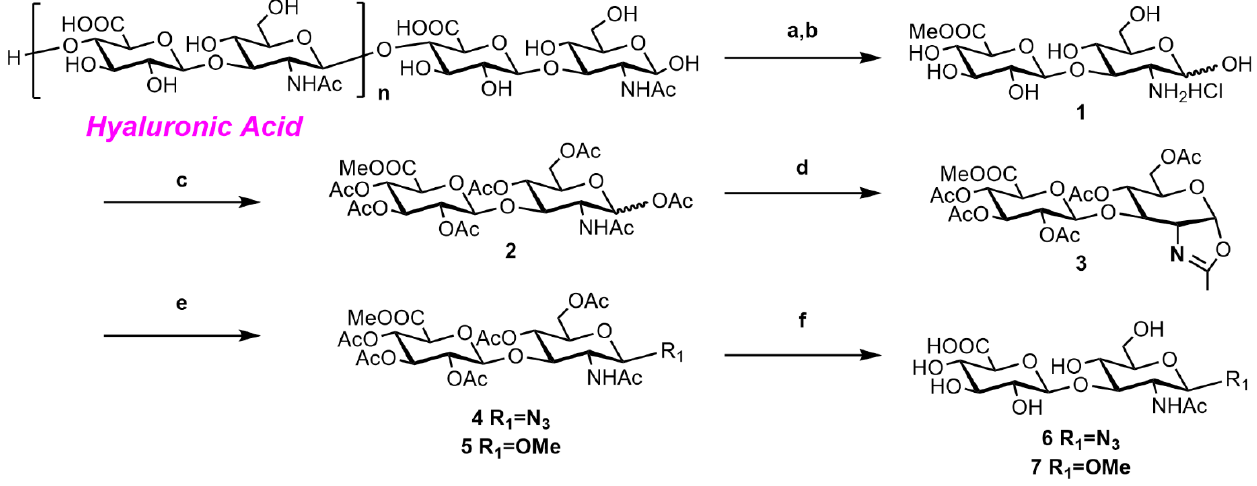
Figure 2. Synthesis of o-HA 2 OMe ( 6 ) and o-HA 2 N 3 ( 7 ). Reagents and conditions: ( a ) 0.5 M HCl, 80